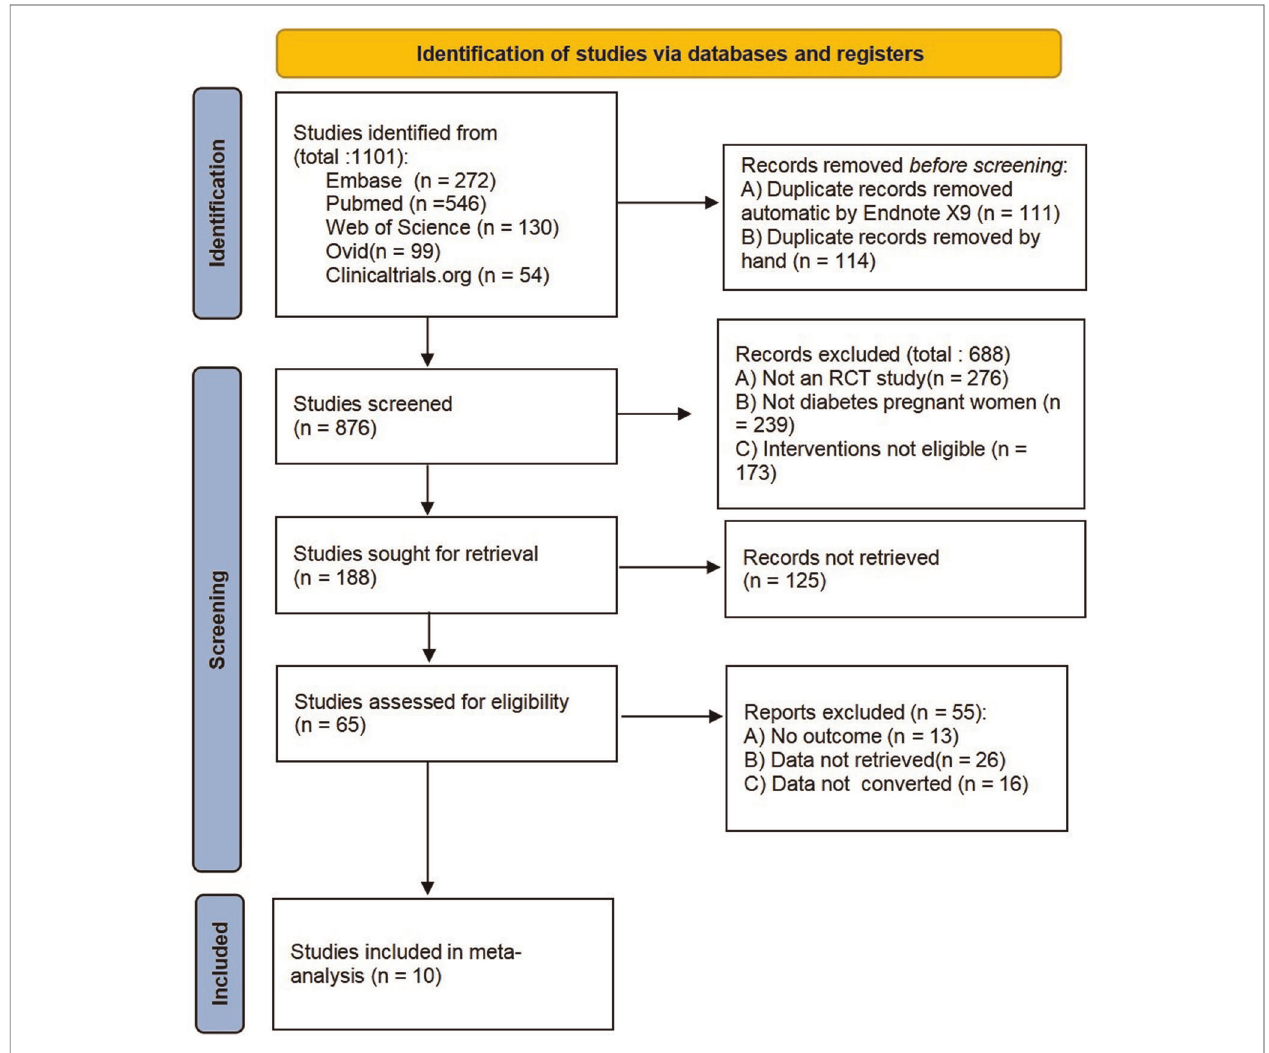
FIGURE 1 | The selection fl ow